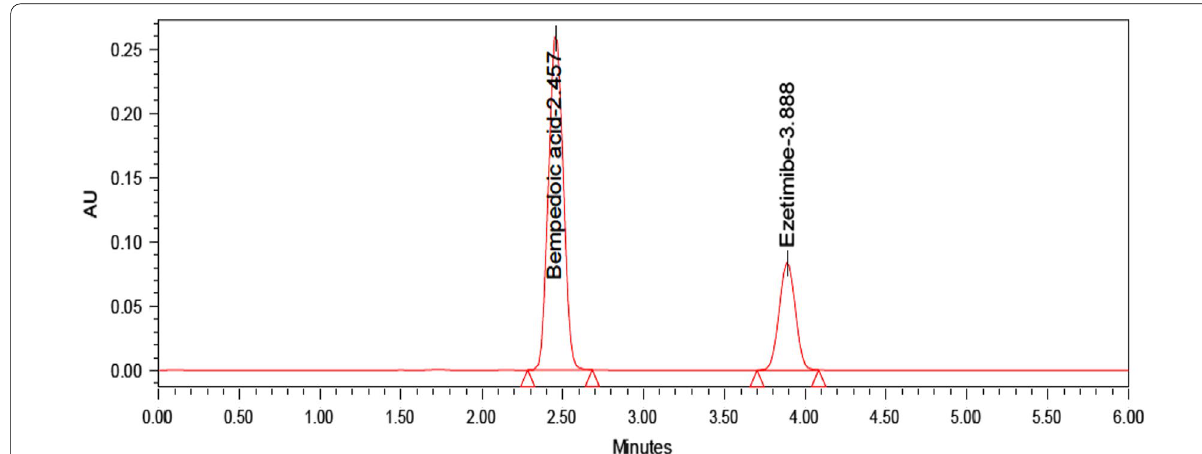
Fig. 2 Standard chromatogram of